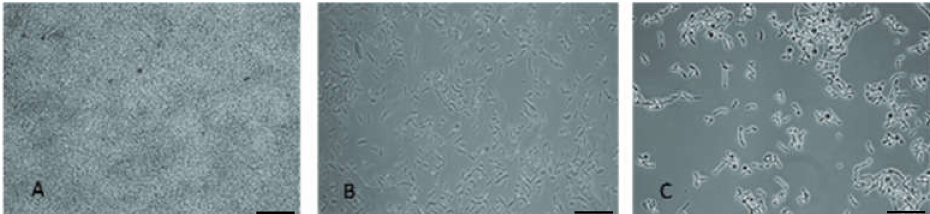
Figure 3. Light microscopy images of T. cutaneum dynamic biofilm treatment in the flow cell experi- ment: ( A ) control, ( B ) after 2 h of rhamnolipid rh3777 treatment, ( C ) after 16 h of rhamnolipid rh3777 treatment. Scale bar 100 µ